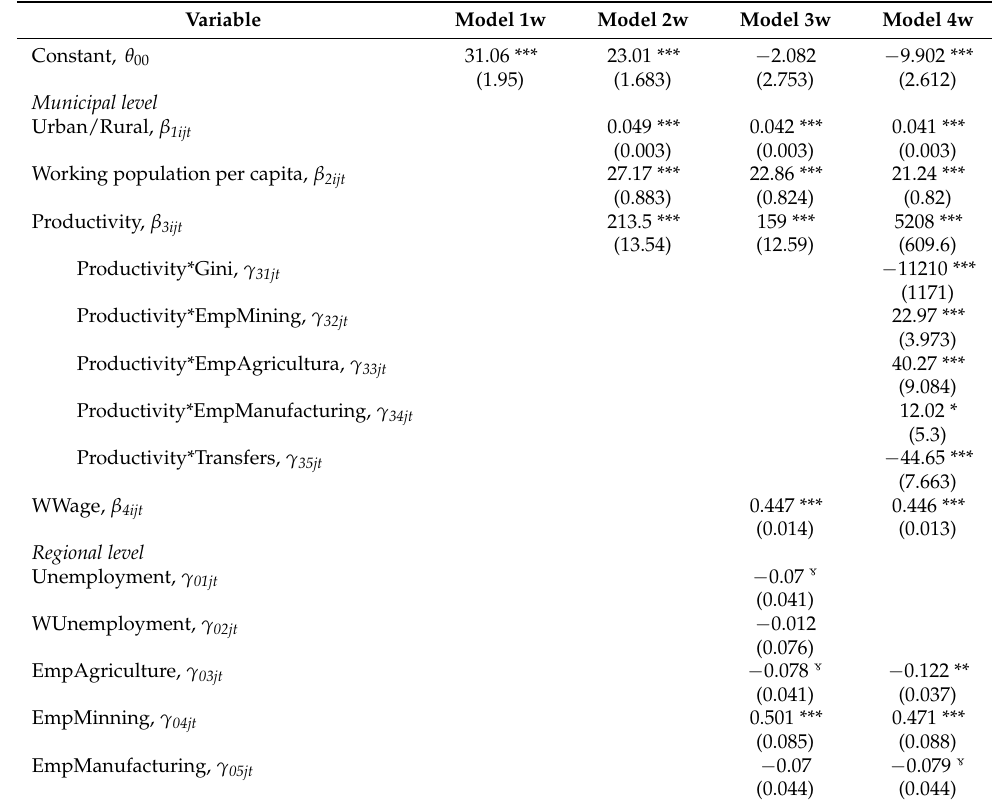
Table 4. Modelling results (dependent variable: Average